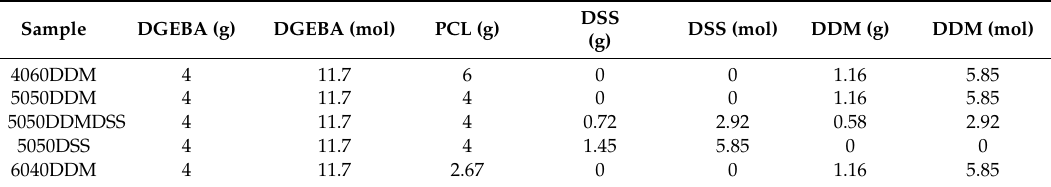
Table 3. Composition of the prepared